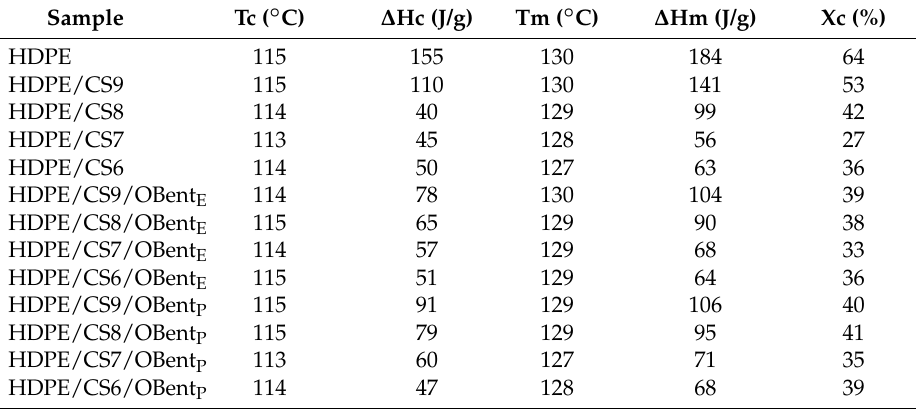
Table 2. Differential scanning calorimetry (DSC) data for high density polyethylene (HDPE), and HDPE/CS